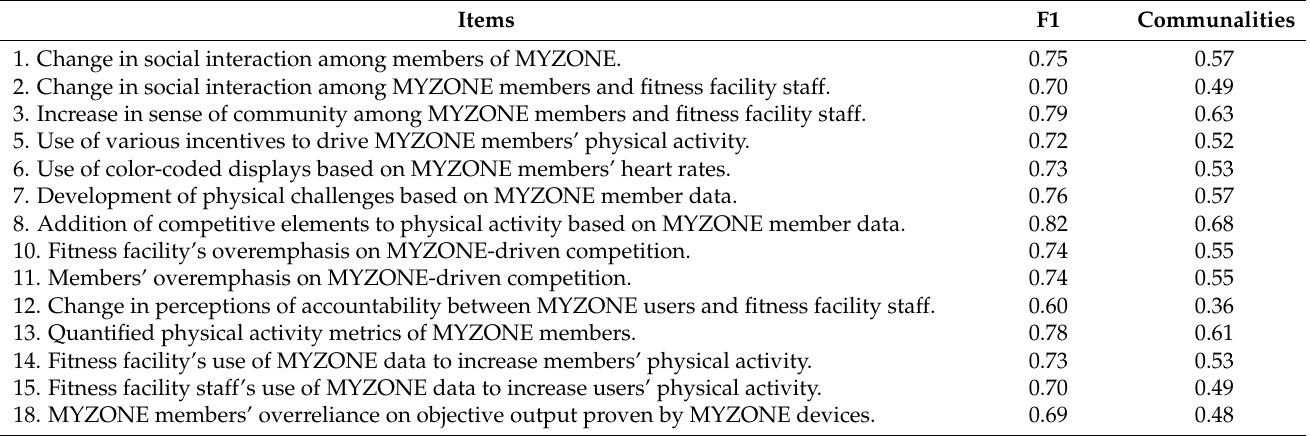
Table 3. Exploratory Factor